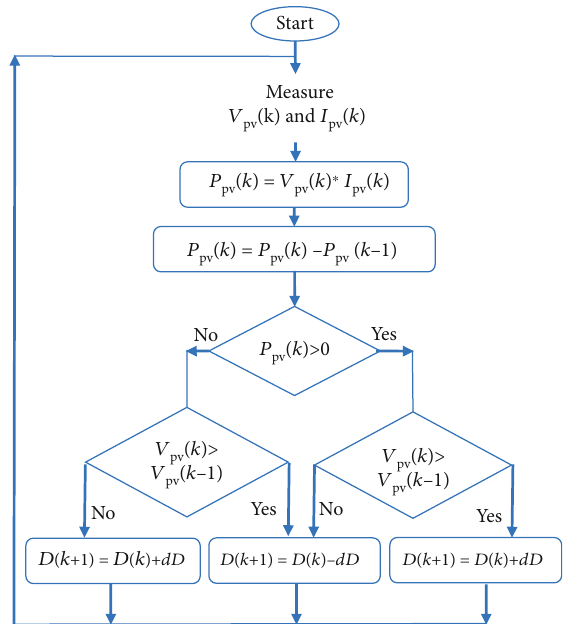
Figure 5: Flowchart of the basic perturb and observe (P&O)